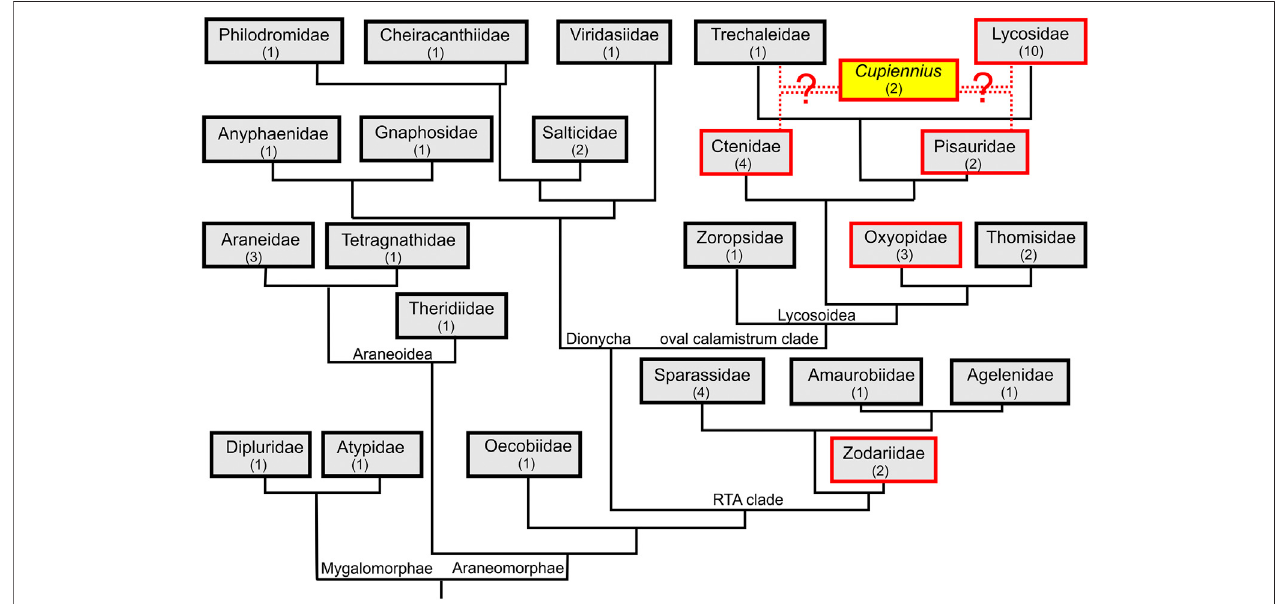
FIGURE 1 | Truncated spider phylogeny with mapped presence of LPs. We investigated from all shown spider families the venom gland transcriptome of one or more spider species to identify linear peptide (LP) precursors. Families, in which LP precursors were identi fi ed are boxed in red and spider family transcriptomeswithout LP precursors are boxed in black. Numbers in brackets refer to the number of spider species per family. The phylogeny follows (Wheeler et al., 2017; Cheng and Piel, 2018; Fernández et al., 2018). The phylogenetic position of the genus Cupiennius is still under discussion.